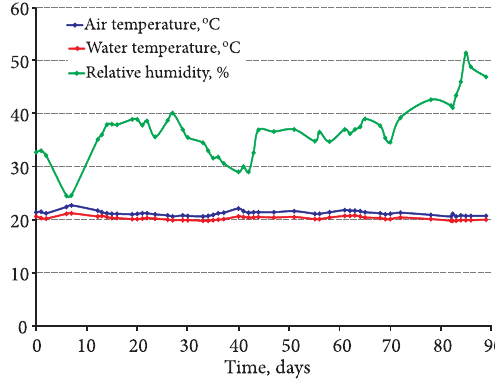
Fig. 3. Water, air and relative humidity dependence on time